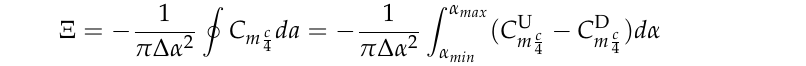
Figure 19. Energy coefficient variation in a cycle for various mean angles of attack, two reduced frequencies (0.1 and 0.2) and Re = 0.5 × 10 5 . Mean angle of attack (from left to right): α m = 0°, α m = 5°, α m = 10°, α m = 15°.